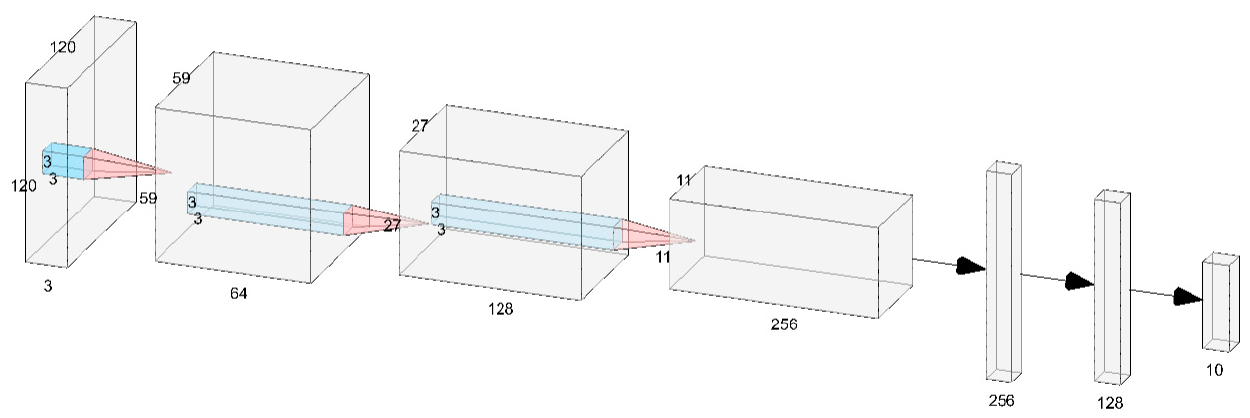
Figure 12. Winning model